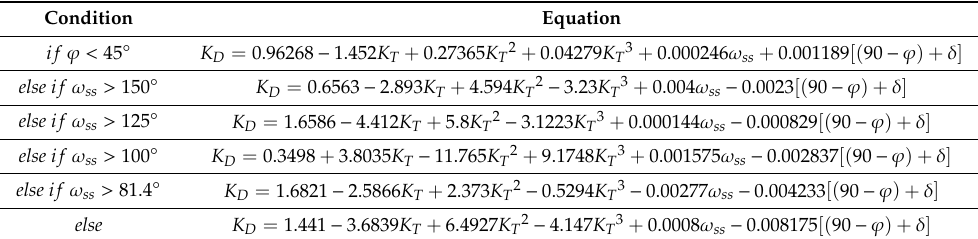
Table 3. Conditional table to determine the di ff usion index ( K D )